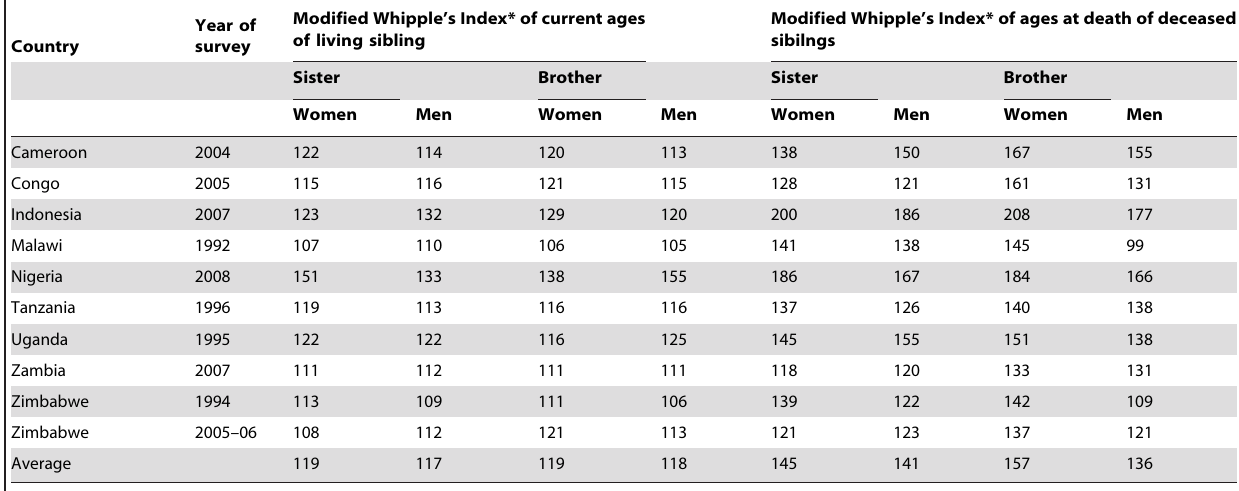
Table 6. Age reporting distortion in sibling histories obtained from women and men.